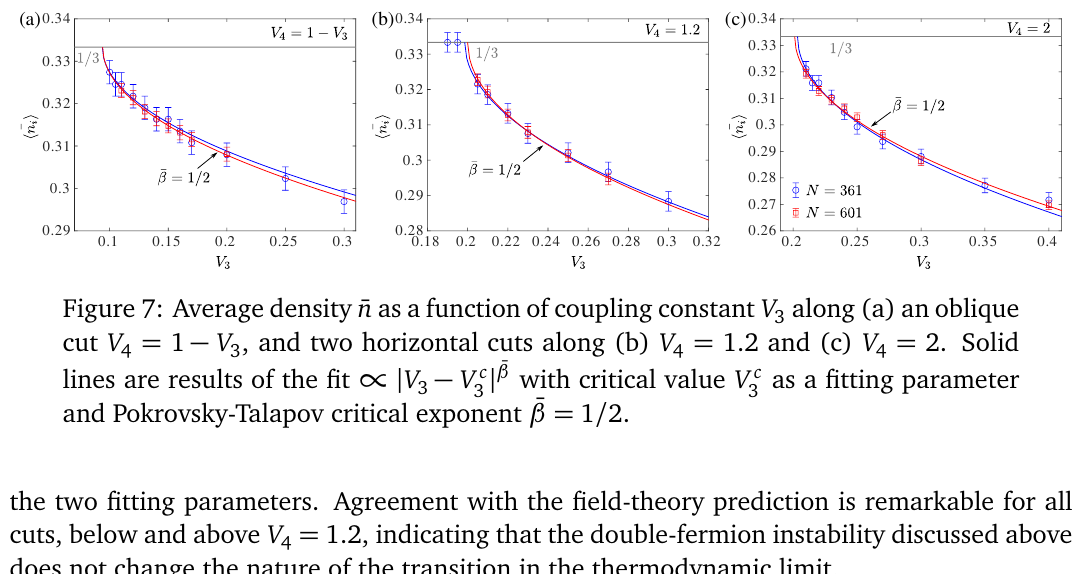
− V c | ¯ β with critical value V c 3 3